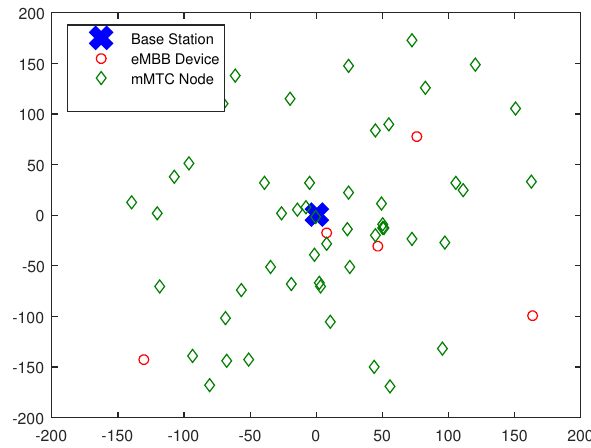
Figure 2. Distribution of eMBB devices and mMTC devices in cellular